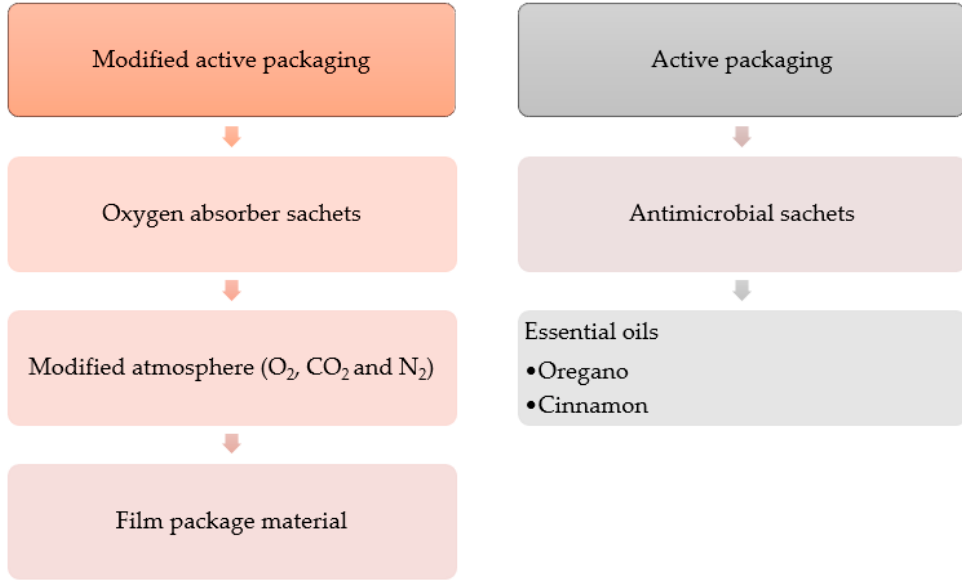
Figure 3. Summary of packaging materials to extend bread’s shelf life.